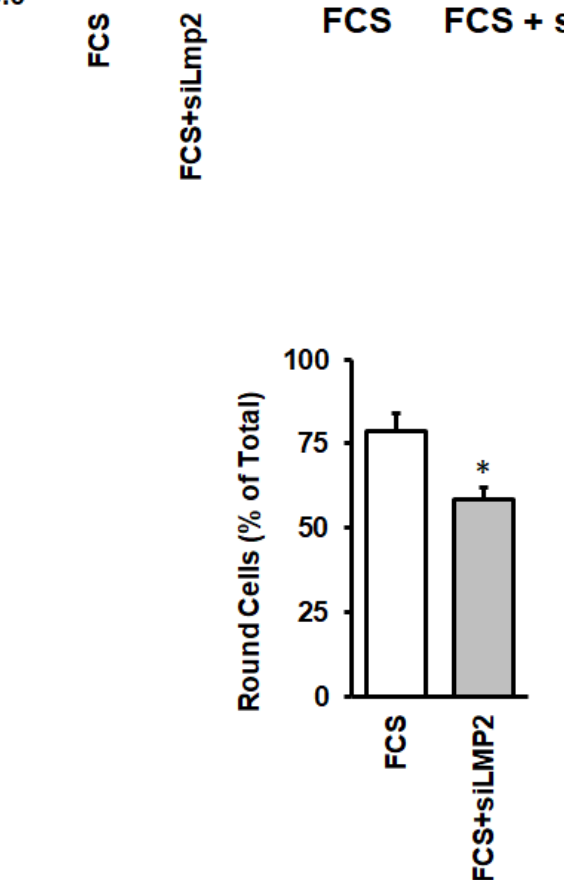
Figure 7. Effect of siRNA directed against LMP-2 on LMP-2 expression and cell rounding in cultured cardiomyocytes. ( A ) LMP-2 protein expression normalized to GAPDH; ( B ) Original Western Blot showing the expression of LMP-2; ( C ) Number of round cells after incubation with FCS or FCS and siRNA directed against LMP-2. Data are means ± SD from n = 5 preparations. *, p < 0.05 vs. FCS. 3.5. Induction of LMP-2 during the Adaptation of the Left Ventricle to Pressure Overload Finally, we investigated the expression of LMP-2 in a model of cardiac hypertrophy. Spontaneously hypertensive rats (SHR) were analyzed at the age of 1.5 (pre-hypertensive state) to 7.0